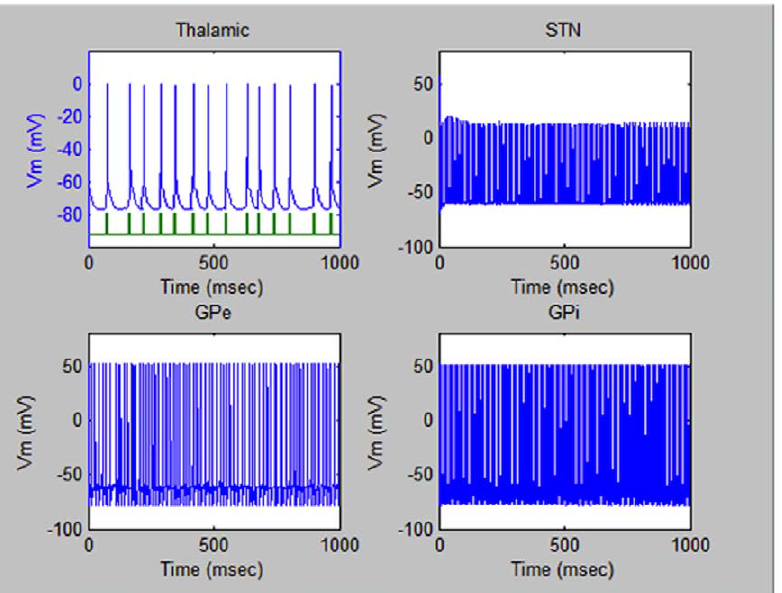
Figure 5. Electric pulses of a Parkinson’s patient after the invasive DBS treatment. Typical electric pulsed sequences triggered in the four regions of the brain under study of a patient suffering from Parkinson’s Disease after a treatment by the invasive DBS procedure with electric signals.